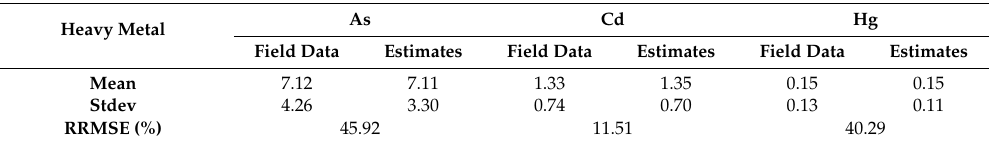
Table 3. The accuracy of the model fitting based on the field measurements of the soil heavy metal content from the 65 training soil samples.